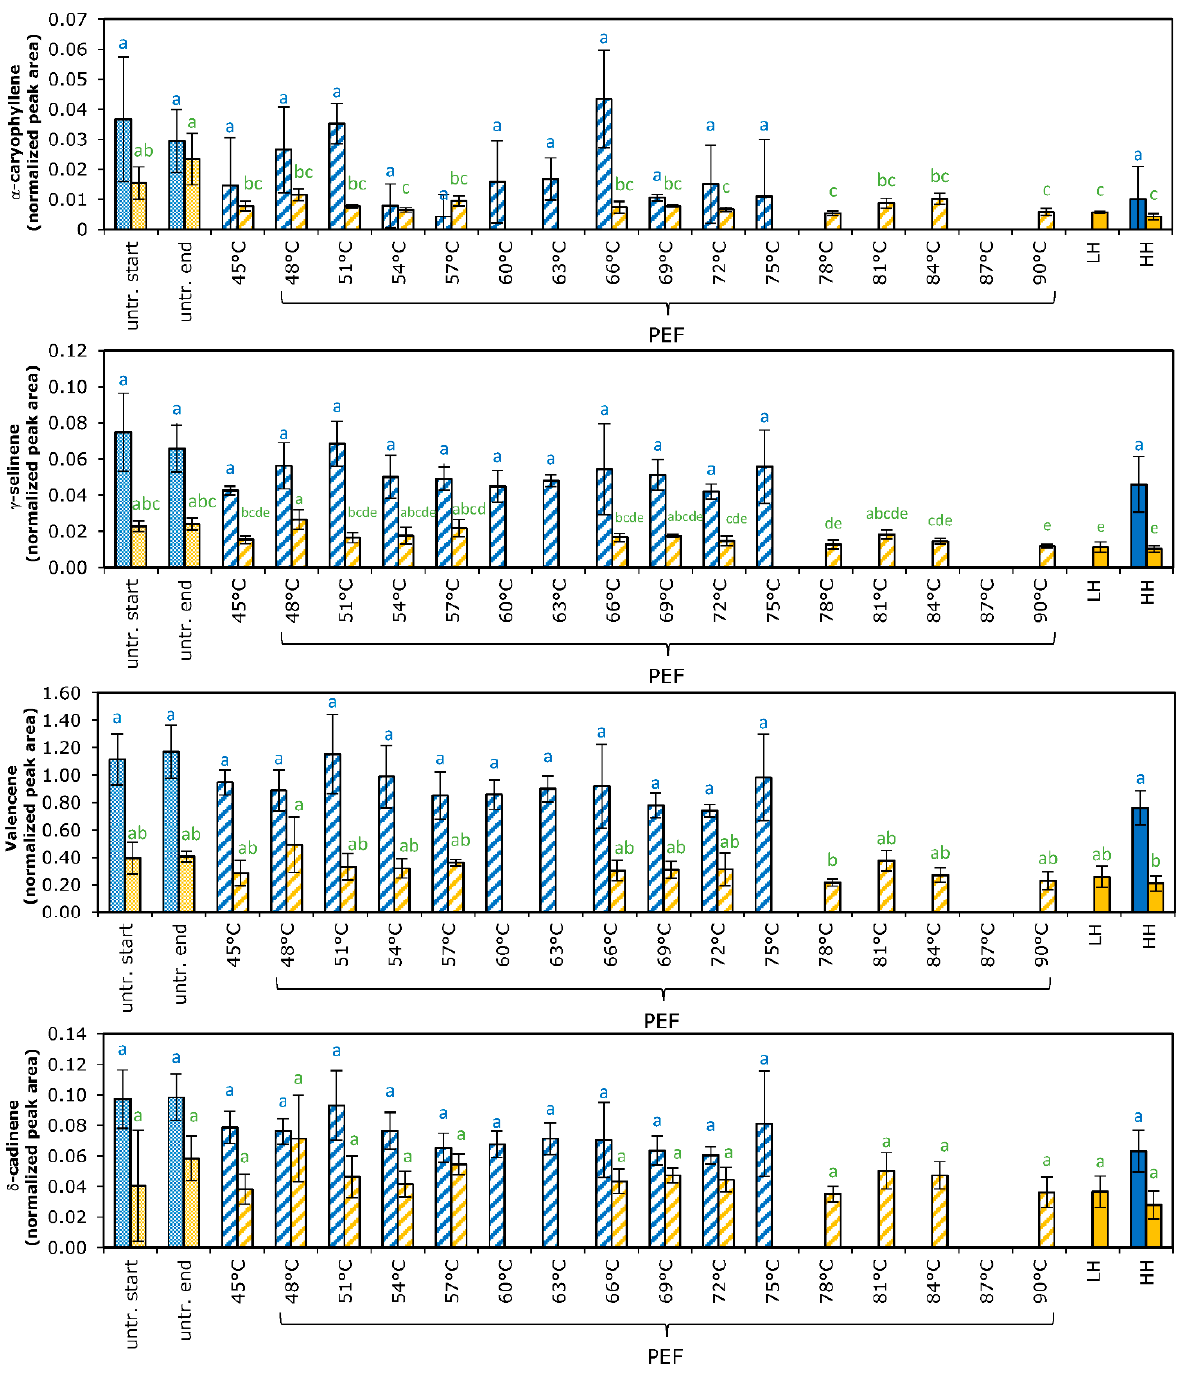
Figure A1. Effect of processing on each detected flavor compound in orange juice. Blue bars represent juice A, orange bars represent juice B. Values of untreated juice at start and end of the day are given. Results of various moderate intensity PEF treatment are given according to the maximum temperatures applied, using E = 2.7 kV/cm (blue bar) and E = 0.9 kV/cm (orange bar). Thermal treatments are indicated as LH for low heat treatment (75 °C—20 s) and HH for high heat treatment (95 °C—20 s). Bars represent the average of three measurements with standard deviation. Trends for each treatment and juice are shown in Table 2. Statistical differences between the treatments are indicated with a letter per juice, with matching letters showing no significant difference.